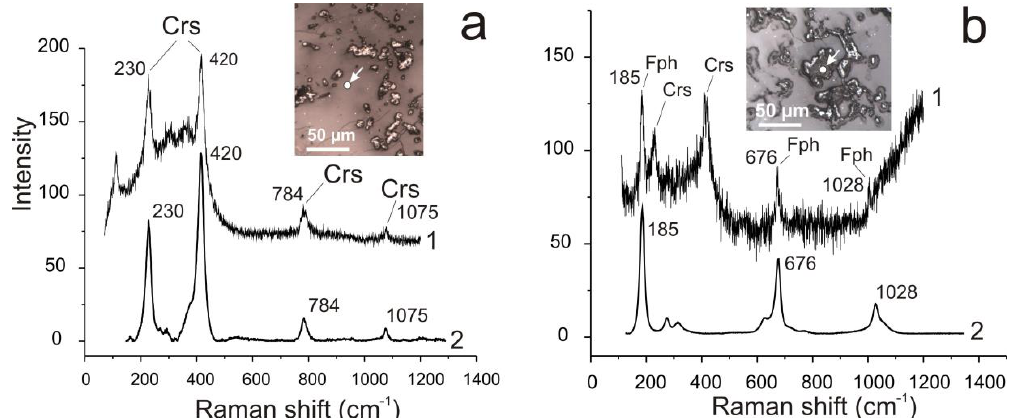
Figure 10. Raman spectra of “moss” aggregates in semitransparent ( a ) and cristobalite areas ( b ) in the thin section fragment of agate No. 4 (Figure 4b,e). The exposure sites are taken in reflected light. ( a ) a spectrum of SiO 2 in a semitransparent area (1) together with an cristobalite spectrum (2) from the RRUFF database the spectrum R060648 [39] (https: // rru ff .info / ); ( b ) the combined spectrum of cristobalite and fluorophlogopite (Fph) (1) in the cristobalite area, compared with the spectrum of fluorophlogopite (2) from the RRUFF database, the spectrum R040075